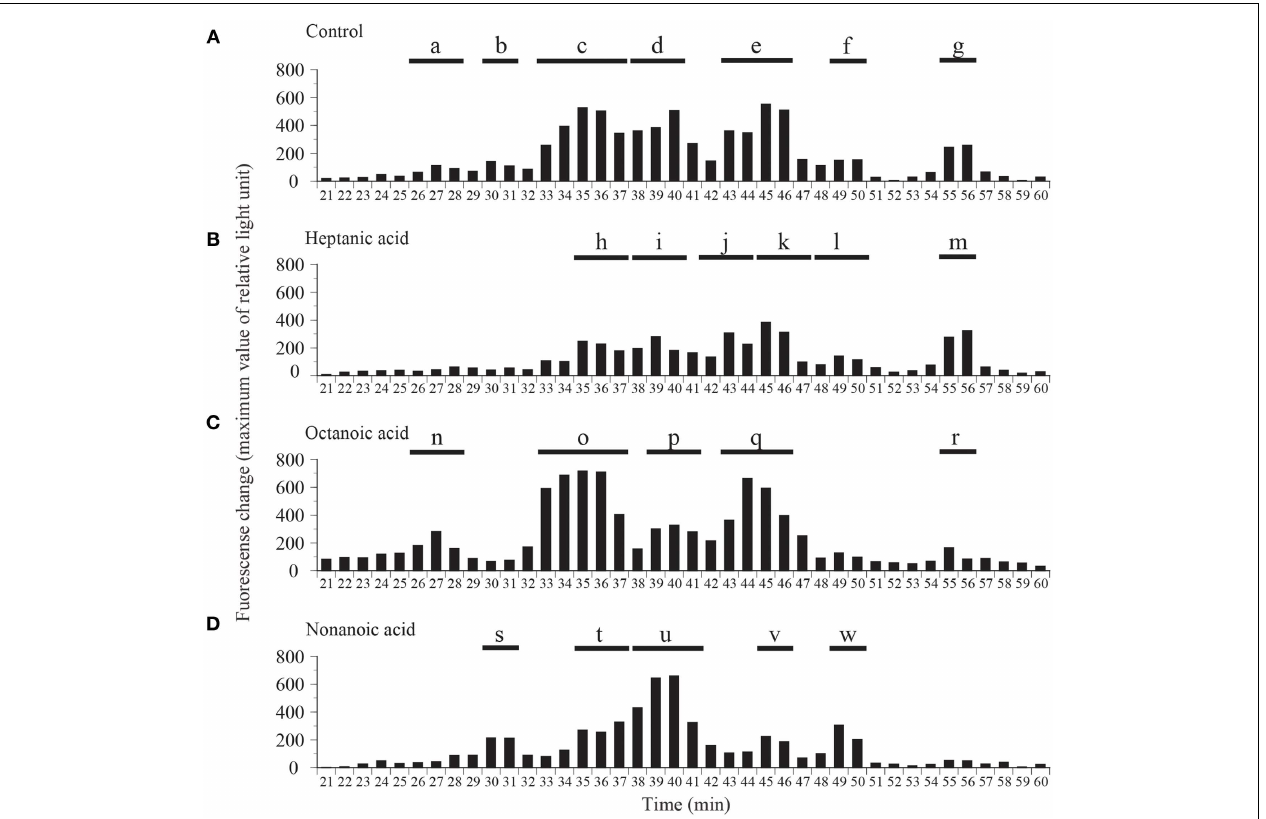
assigned to groups a–w on the basis of their ghrelin activity. Ghrelin activity in the equivalent of 400mg stomach tissue is expressed in terms of fluorescence change in CHO cells expressing rat GHS-R1aThe maximum changes in fluorescence are